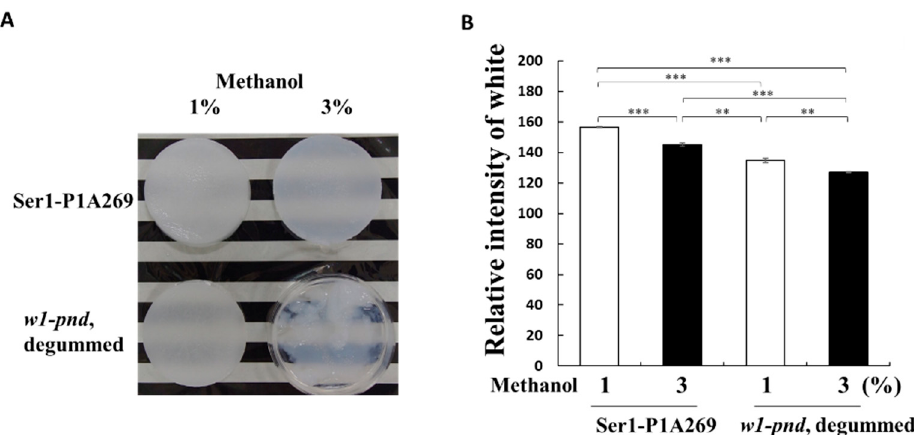
Figure 3. Superiority of cocoons with a high fibroin content for the formation of fibroin sponges. ( A ) Comparison of the appearance of sponges of degummed w1-pnd and non-degummed Ser1-P1A cocoons formed with 1% or 3% ( v / v ) methanol. ( B ) Transparency analysis of sponges prepared from the Ser1-P1A269 cocoon and degummed w1-pnd by using 1% and 3% ( v / v ) methanol. Transparency of the sponges was measured using computer-assisted image analysis software. Data are the means ± SD of relative intensity; n = three independent samples. ** p < 0.01 and *** p < 0.001 (one ‐ way ANOVA, followed by Tukey’s test).